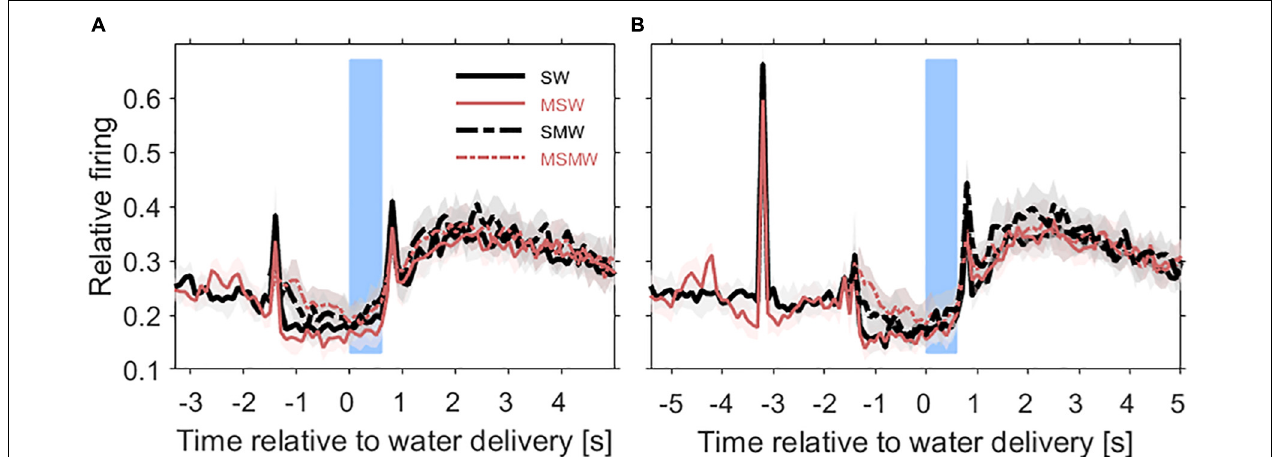
FIGURE 3 | Population firing rates relative to the time of water delivery in the four conditions of the task block. Results are from 180 multiunits in the auditory cortex of two instrumentally-trained monkeys and are shown for the SW-condition (black solid curve), the MSW-condition (red solid curve), the SMW-condition (black dashed curve), and the MSMW-condition (red dashed curve) in tone-alone trials (A) and in noise-tone trials (B) . Other conventions as in Figure 1 . Note that in the SW-condition and MSW-condition, the firing peak ∼ 1.5 s before water delivery reflected the sound-evoked response. In the SMW-condition and MSMW-condition, this peak reflected the motor response to the